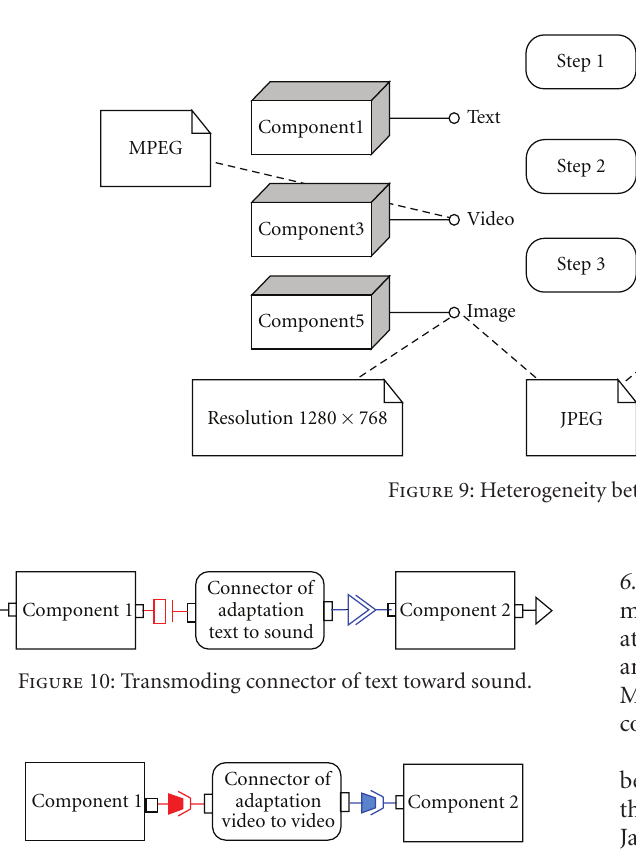
Figure 8: A configuration with multiple connections working in parallel and in sequence.